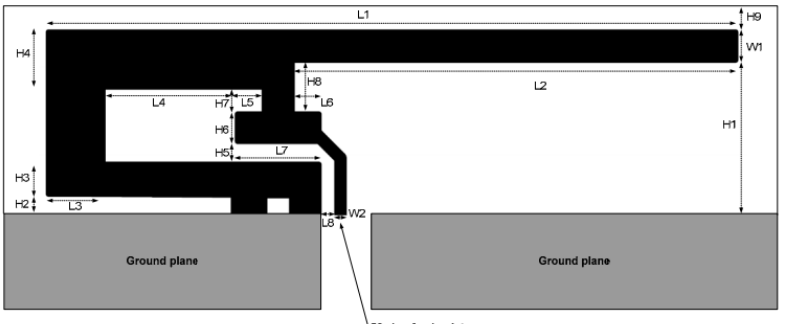
Figure 3. The application of the integrated radio components.